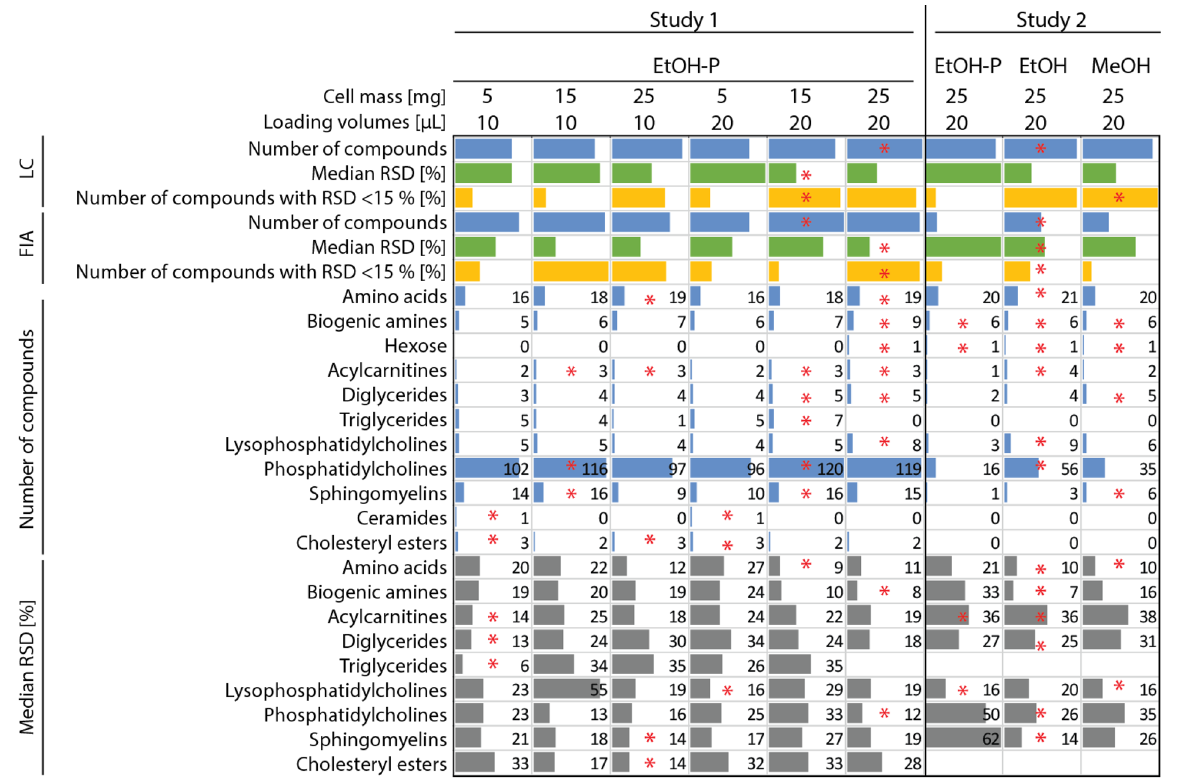
Figure 4. Summary of the obtained results from both the cell and volume determination (study 1) and the extraction solvent determination (study 2) in HOS cells. Red stars indicate the best condition either in study 1 or study 2 for the analyzed objects. LC: liquid chromatography. FIA: flow injection